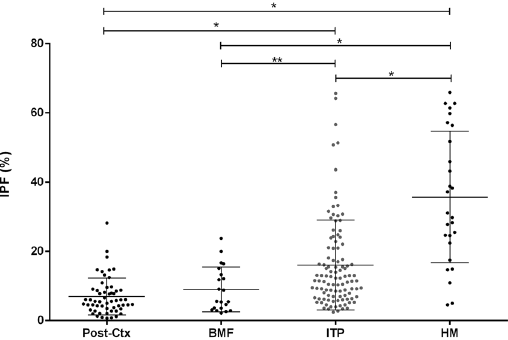
Figure 1. Immature platelet fraction (%) of patients with different causes of thrombocytopenia; Post- Ctx: post chemotherapy; BMF: bone marrow failure; ITP: immune thrombocytopenia; HM: hereditary